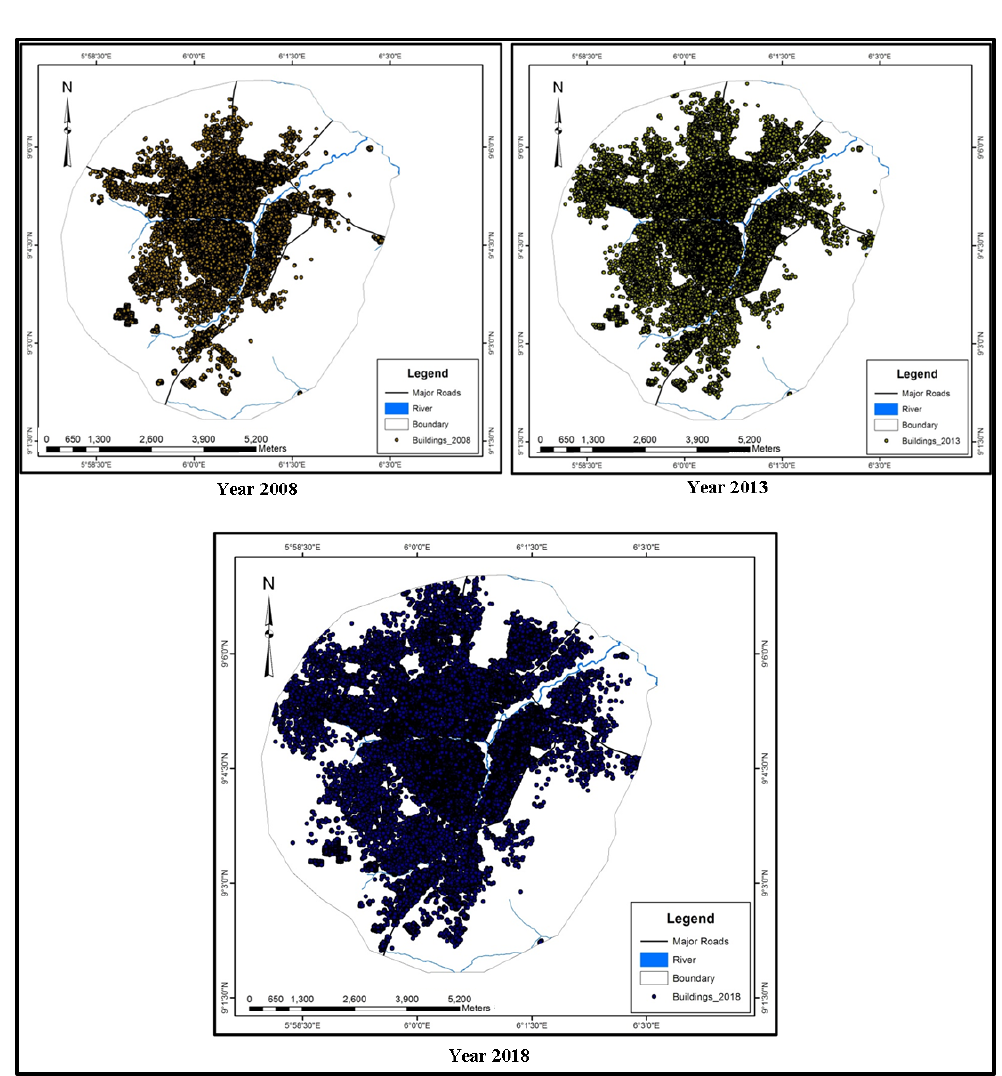
Fig. 2. Location of buildings in the study area for the year 2008, 2013 and 2018 (Field survey,